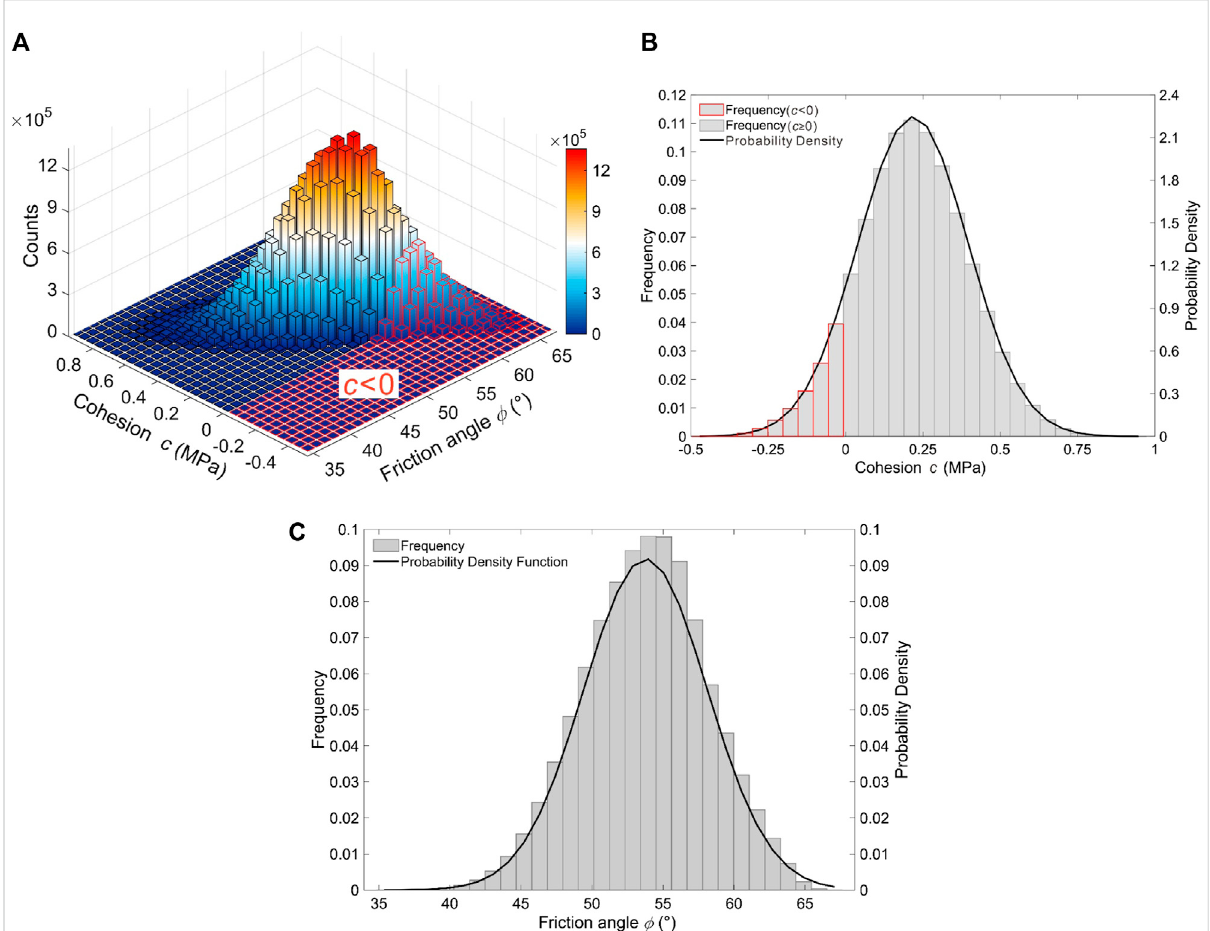
FIGURE 6 Distribution of the apparent cohesion and friction angle based on rock joint combinations each containing 5 specimens. (A) Distribution of the apparent cohesion and friction angle; (B) Distribution of the apparent cohesion; (C) Distribution of the friction